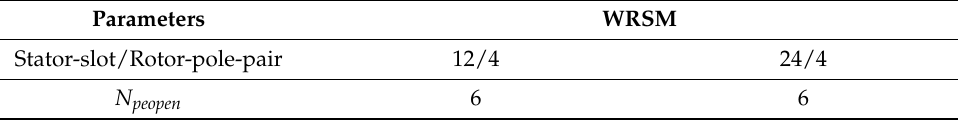
Table 2. Predicted N peopen for the Analyzed WRSMs.